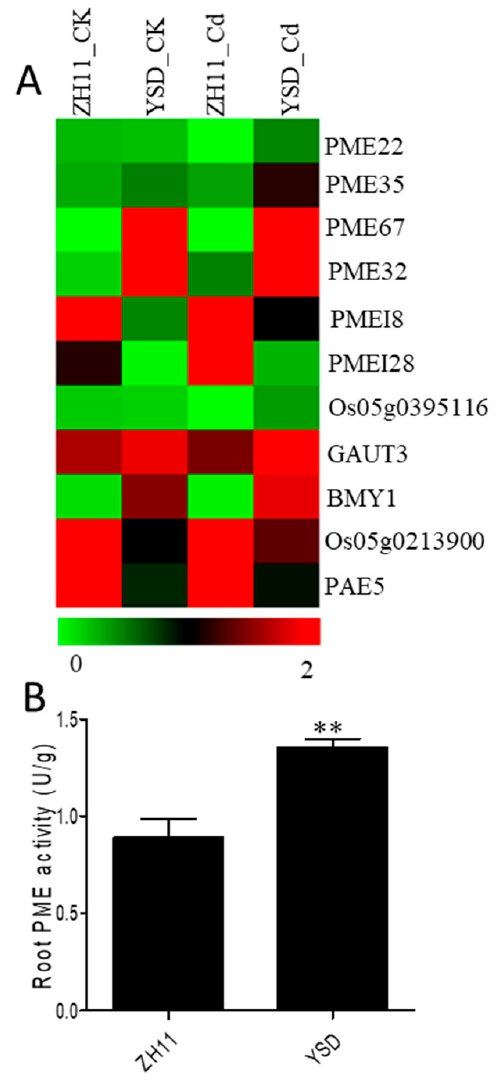
Figure 6. Differentially expressed genes (DEGs) involved in cell wall pectin metabolism and PME activity between YSD and ZH11 root under Cd treatments. ( A ) Transcriptional profiling of pectin methylesterase (PME 22/PME35/PME67/PME32), pectin methylesterase inhibitor protein (PMEI8/PMEI28), pectate lyase (Os05g0213900/PAE5) and pectin biosynthesis (CAUT3/BMY1). ( B ) PME activity in leaves of 30-day-old rice treated with 10 μ M CdCl 2 for 3 days. Data are presented as the means of 3 independent biological replicates (n = 3) and vertical bars represent the SD., ** indicates significant differences between the cultivars at p < 0.01.